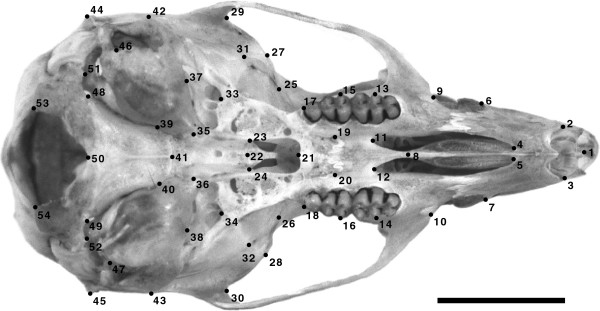
Landmarks used to characterize the ventral skull of A. mollis. Landmark description is provided in Additional file 4 Scale bar = 5 mm.